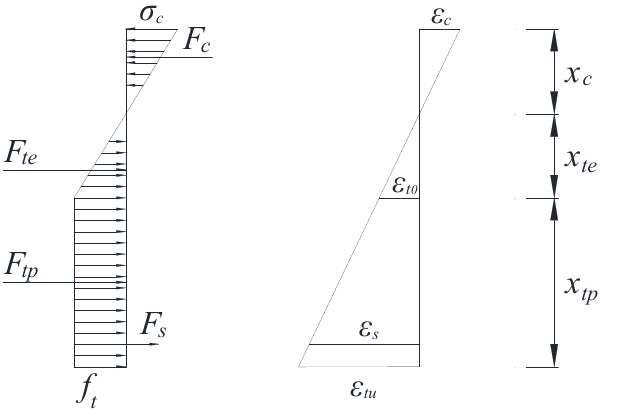
Figure 5. Simplified calculation model of normal section. Equation (7) can be derived from the equilibrium condition of the Based on test data, the flexural initial cracking tensile strains of Beam-1, Beam-2 and Beam-3 are 495.0 με , 491.8 με and 478.4 με , respectively. The ratios of the flexural initial cracking tensile strain to the peak tensile strain (213 με ) of the basalt fiber polymer-mod- ified RPC are 2.32, 2.31 and 2.25, respectively. The average value was taken as 2.29. Thus, ε ε= can be obtained. The combined force and bending moment of each part of 2.29 tu t 0 the reinforcement basalt fiber polymer-modified RPC beam are shown in Equation (5) and Equation (6), respectively.